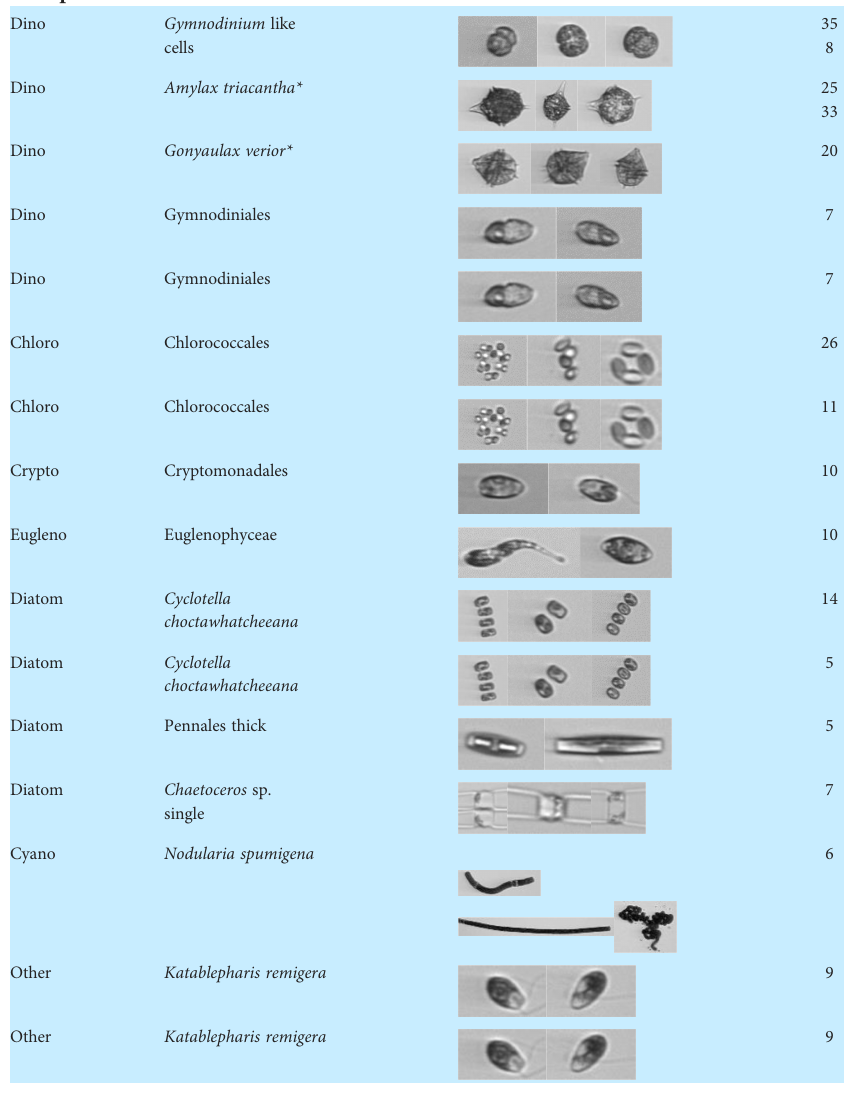
TABLE 2 Class pairs with the highest number of inter-class classi fi cation errors.